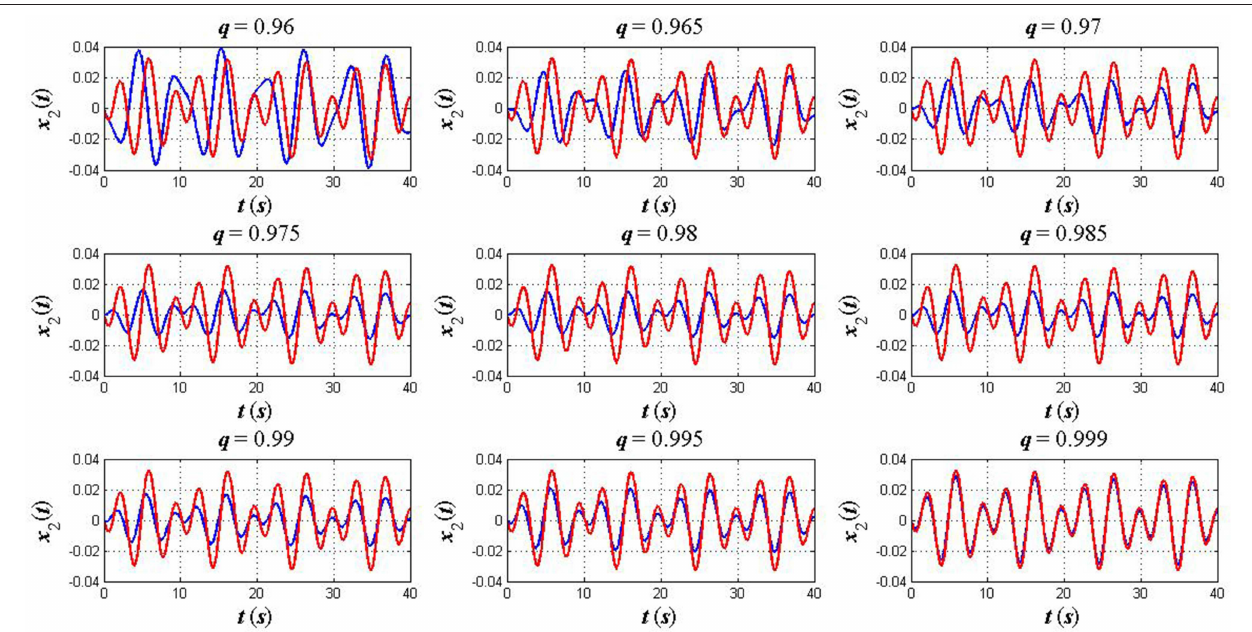
FIGURE 7 | The plots of x 2 ( t ) in the fractional sense (blue) and classical sense (red): a weak coupled oscillator ( k ≫ k 2